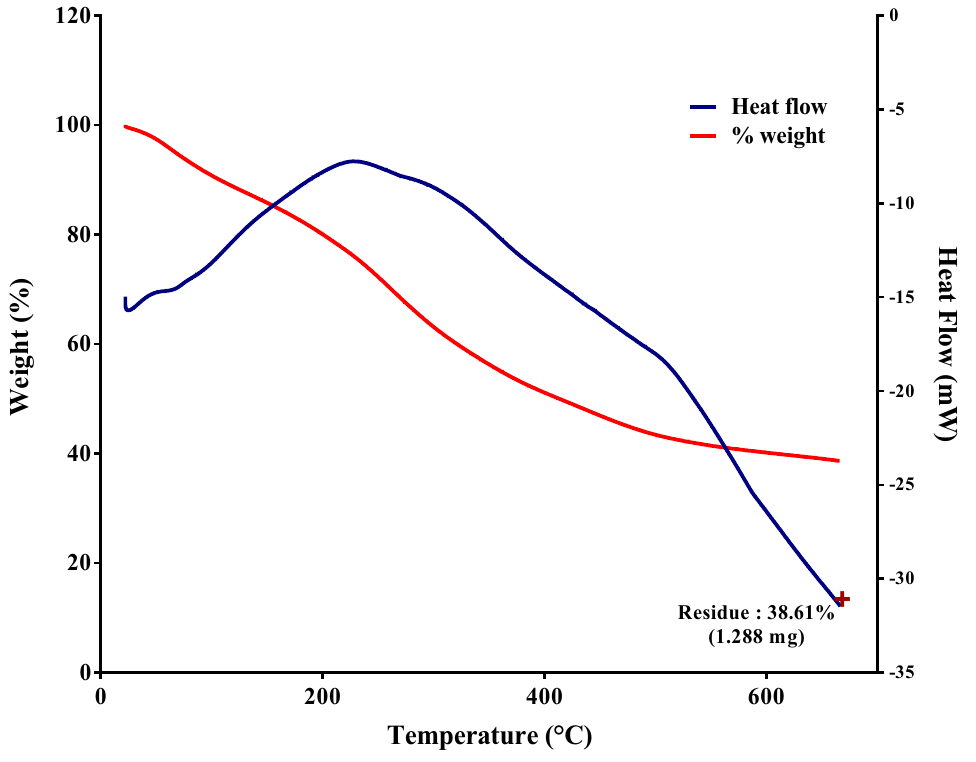
Figure 4. DSC-TGA for Fe 2 O 3 nanoparticles synthesized from Bauhinia tomentosa leaf extract using FeCl 3